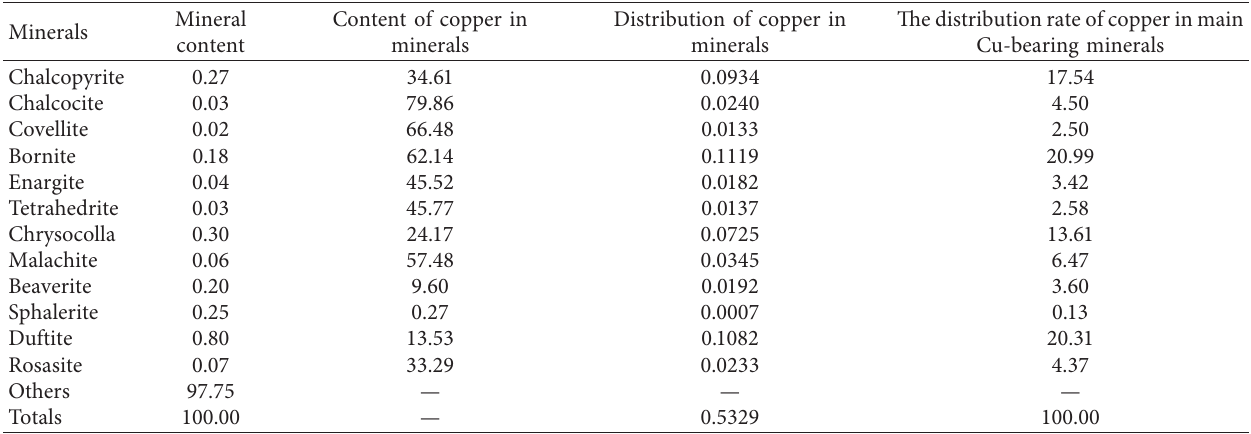
Table 8: Distribution of copper in main Cu-bearing minerals.